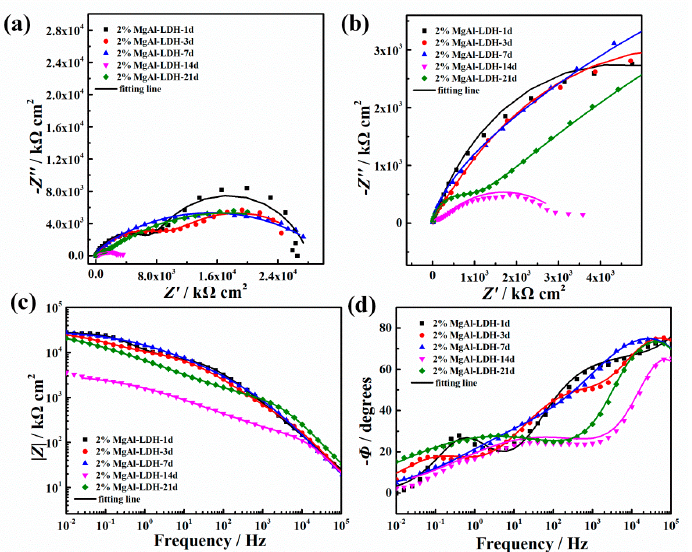
Figure 14. The Nyquist and Bode plots of the epoxy coating with addition of 2% MgAl-LDH during an immersion of 21 d ( a ) Nyquist plots; ( b ) magnification of Nyquist plots at high frequencies; ( c ) Impedance-frequency Bode plots; ( d ) Phase-frequency Bode The EIS spectra of the epoxy sample with 2% ZnAl-LDH was listed in Figure 15. Ac- cording to Figure 15a, the impedance arc increased gradually upon the increased immer- sion time, which can be attributed to the physical barrier effect of the accumulated corro- sion product and the inhibiting effect of the released Zn 2+ cations. It is clear from Figure 15c that the impedance at low frequencies increased from 2.0 × 10 5 k Ω cm 2 to 1.6 × 10 6 k Ω cm 2 when the immersion time was increased from 1 d to 21 d, which was higher than that of the blank epoxy coating. This result indicated an enhanced corrosion protection effect of ZnAl-LDH in the epoxy coating. The Bode plots in Figure 15d also showed three phase angle peaks, therefore, the equivalent circuit with three-time constants in Figure 17b was used to fit the EIS data with the additional time constant corresponding to the Warburg- diffusion impedance.